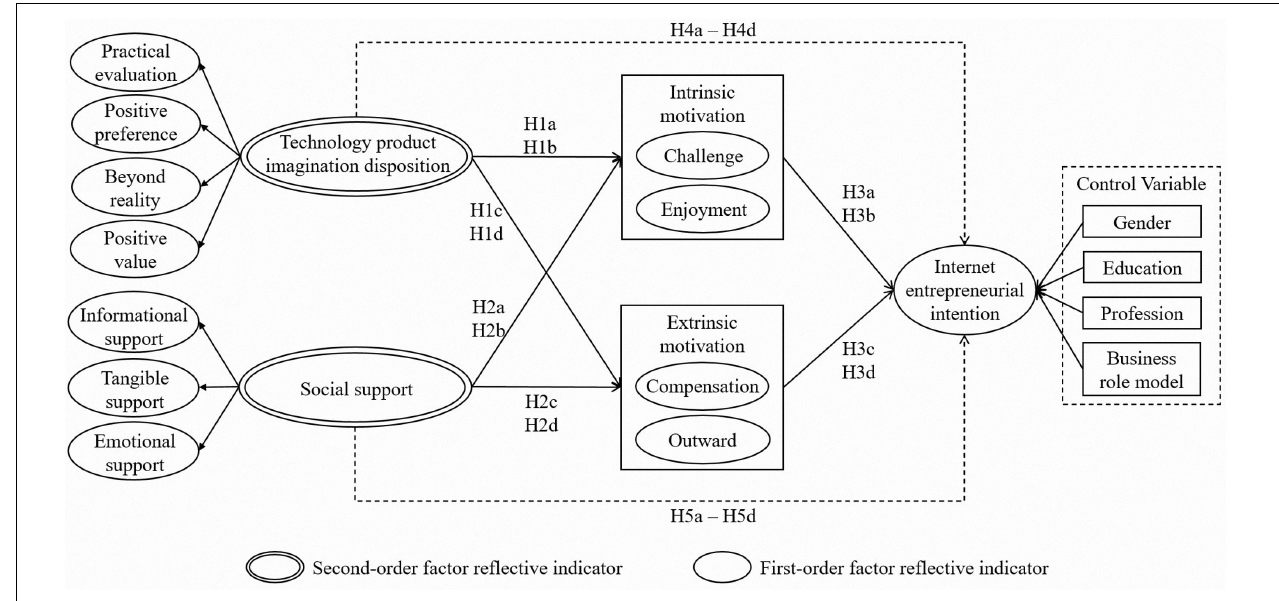
FIGURE 1 | Research